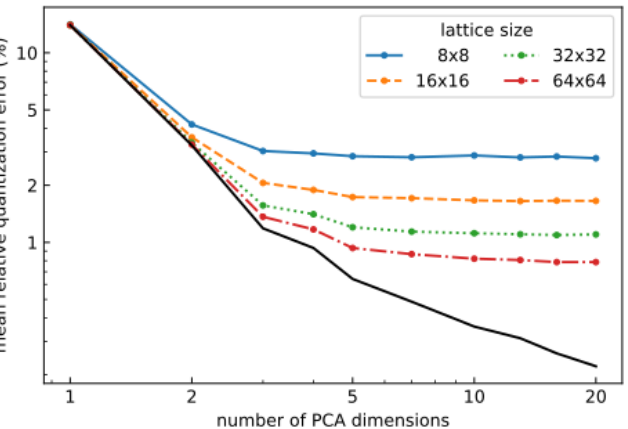
Figure 8. The mean quantization error for four different SOM sizes, for varying numbers of PCA- reduced dimensions. The black line depicts the error imposed by DR itself (prior to applying the SOM), and is thus a lower limit on the